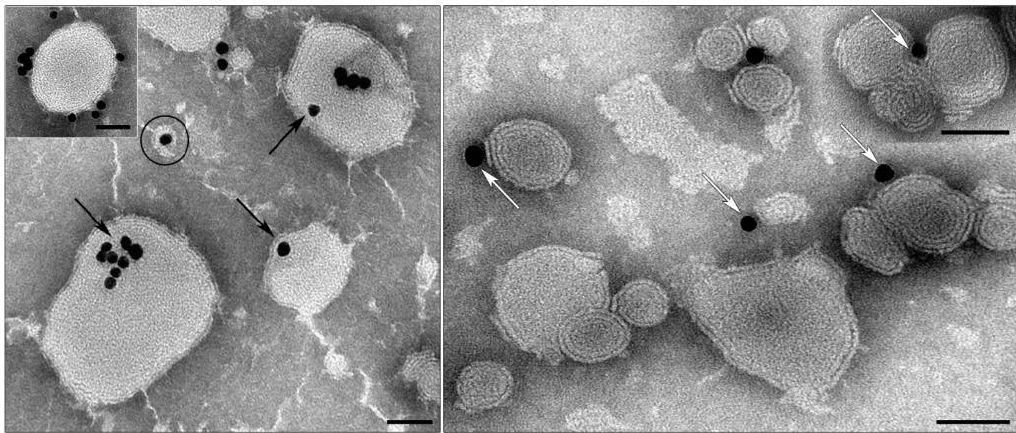
Figure 6. Suspension of siRNA-Au mixed with a suspension of liposomes (PC-lipidoid 3 , 9:1) in citrate buffer with pH 4.5. Black arrows show AuNPs inside liposomes; a particle of desirable morphology is outlined; white arrows show close interaction of AuNPs with liposome membranes; framed insert shows lipid particle with AuNPs on the surface. Lipid particles without AuNPs are also present. TEM, negative staining with PTA. Length of scale bars corresponds to 50 nm.